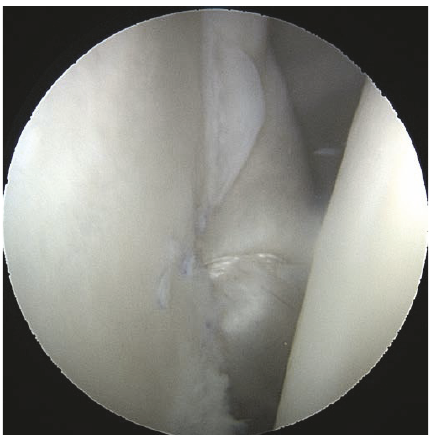
Figure 3: Final intraoperative arthroscopic image after capsular shift.